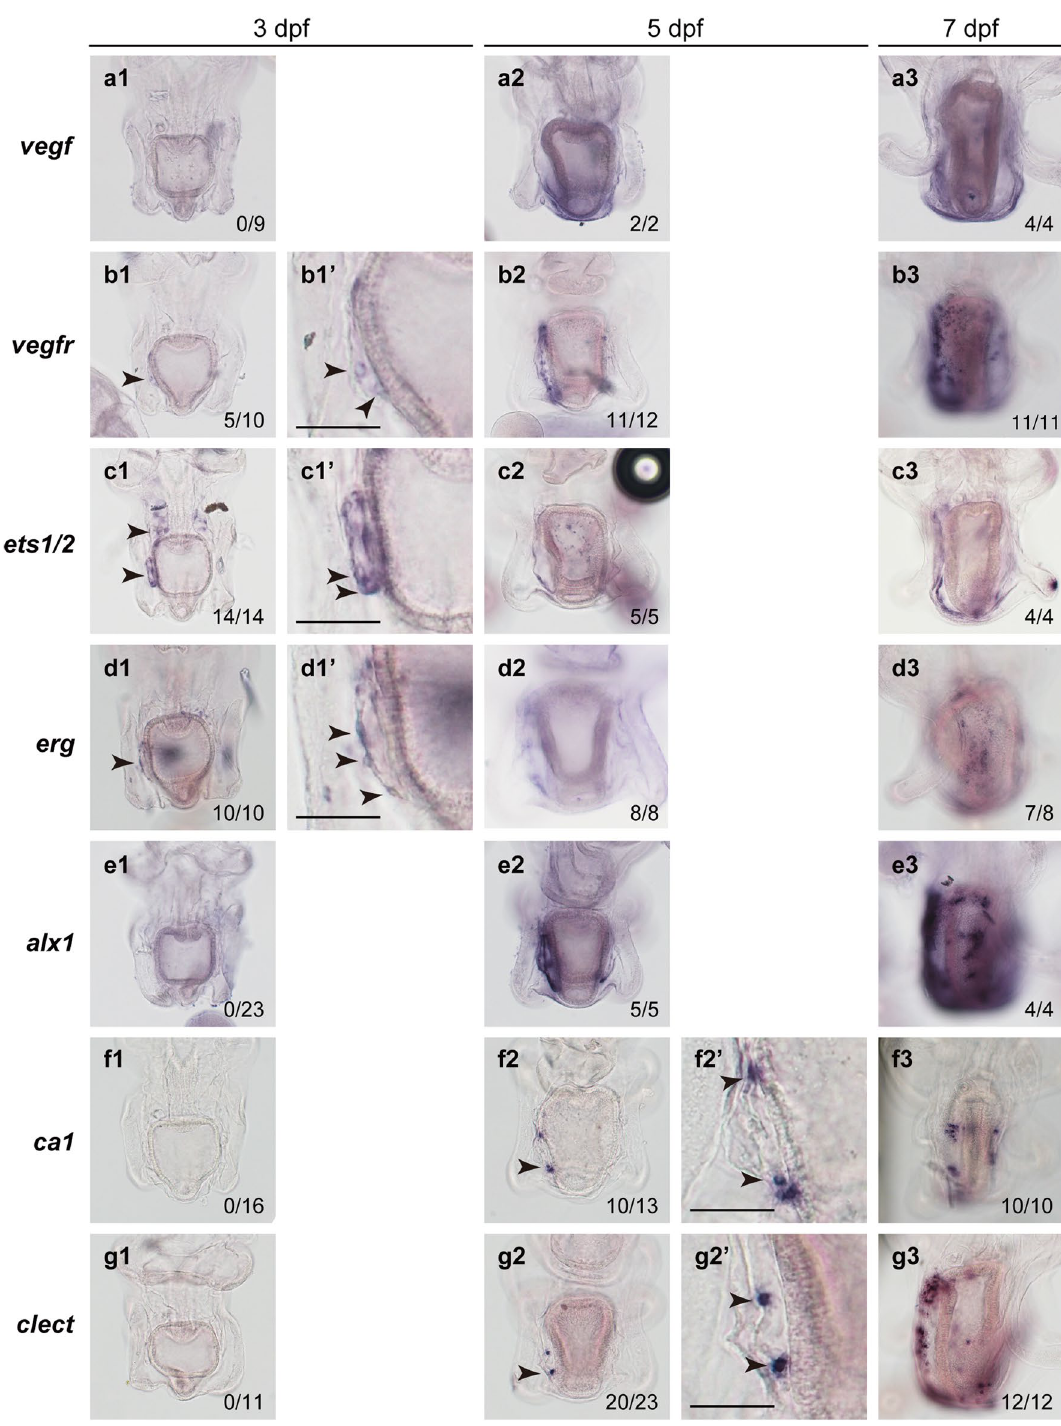
Figure 2. Expression of skeletogenesis-related genes in starfish larvae. Expression patterns of vegf ( a1 – a3 ), vegfr ( b1 – b3 ), ets1/2 ( c1 – c3 ), erg ( d1 – d3 ), alx1 ( e1 – e3 ), ca1 ( f1 – f3 ), and clect ( g1 – g3 ) were examined at 3 dpf ( a1 – g1 , b1’ – d1’ ), 5 dpf ( a2 – g2 , f2’ , g2’ ), and 7 dpf ( a3 – g3 ) by whole-mount in situ hybridization (WMISH). The numbers shown in the lower right corner of each image indicate the number of larvae showing a positive WMISH signal among the larvae examined. Arrowheads indicate the regions or cells expressing each gene. Enlarged images are shown in ( b1’ – d1’ , f2’ , g2’ ). See details in the text. Scale bars: 50